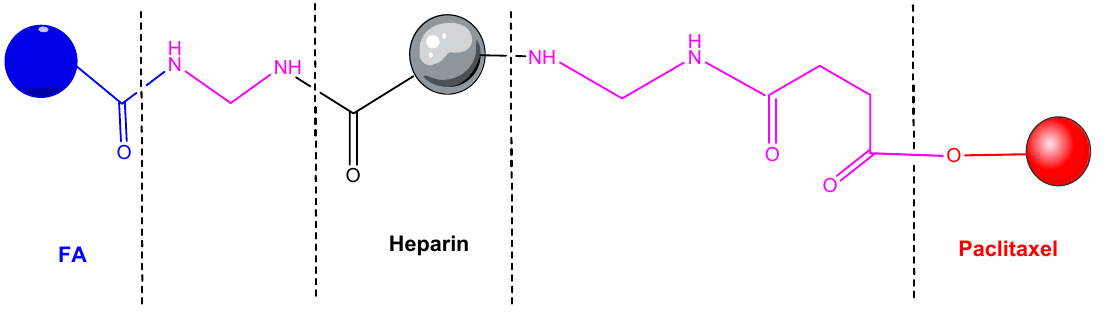
Figure 13. Heparin–folic acid–PTX conjugate [216].